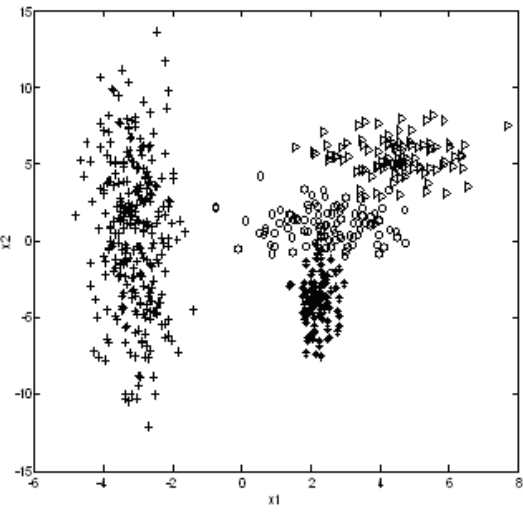
Fig. 3. Two-dimensional artificial case study comprised of 4 fault classes: ‘ + ’ represents patterns of class G t class G t , ‘ ◦ ’ of class G t and ‘ ⊲ ’ of class G t 2 3